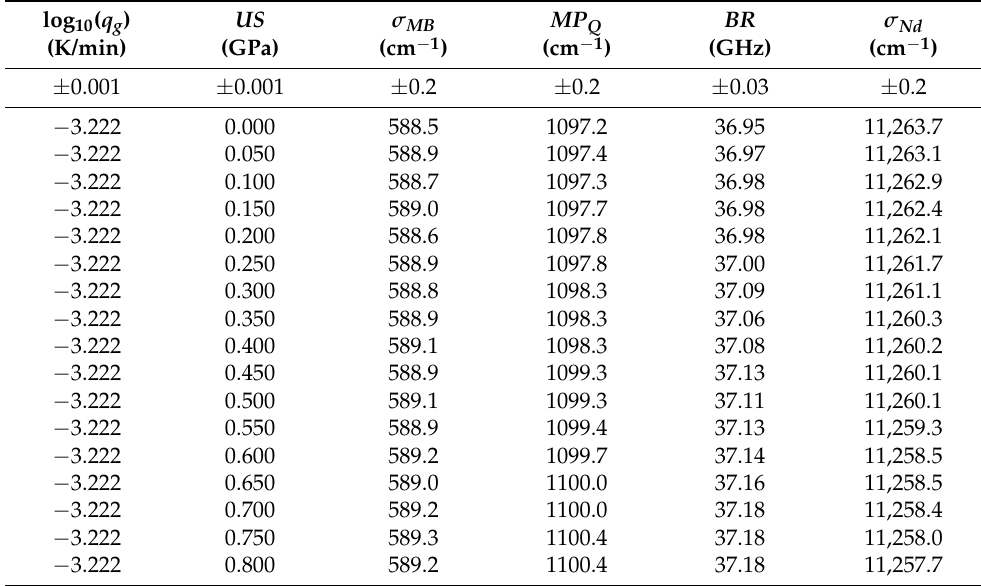
Table A4. Experimental data and spectroscopic observables of the US_annealed sample used for the multiple linear regression